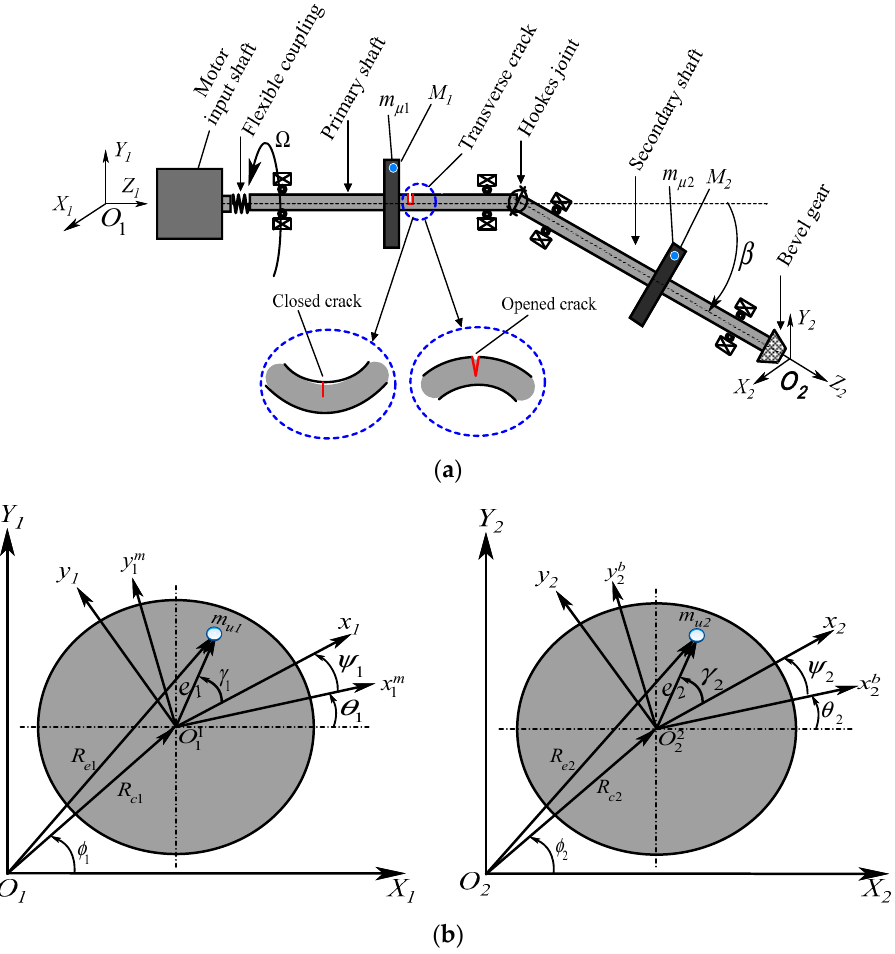
Figure 2. ( a ) Schematic diagram and assembly of the interior of a driveshaft structure. ( b ) Deformed configurations of shaft discs 1 and 2.